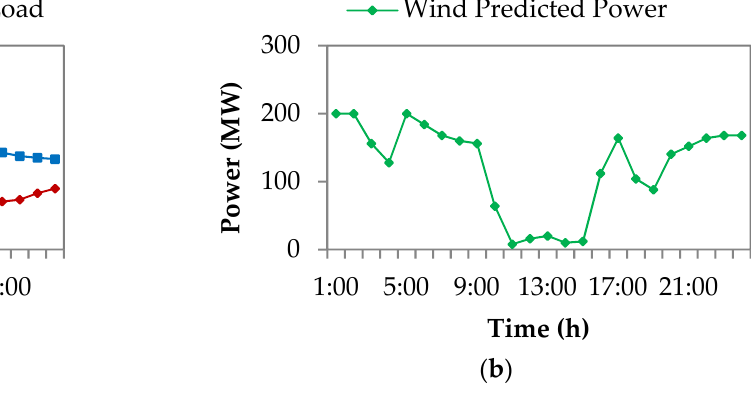
Figure 4. ( a ) Load curve and ( b ) predicted wind power curve.